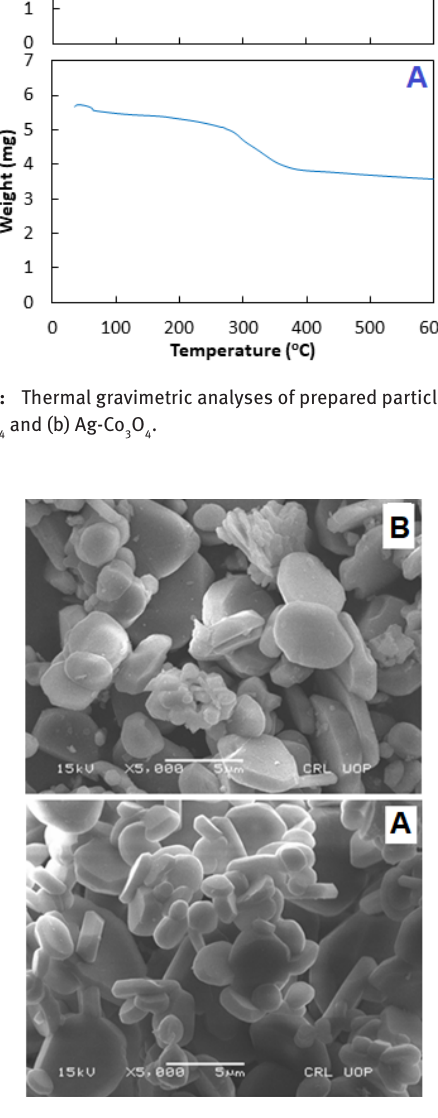
Figure 1: X-rays diffraction patterns of prepared particles (a) Co O and (b) Ag-Co 3 4